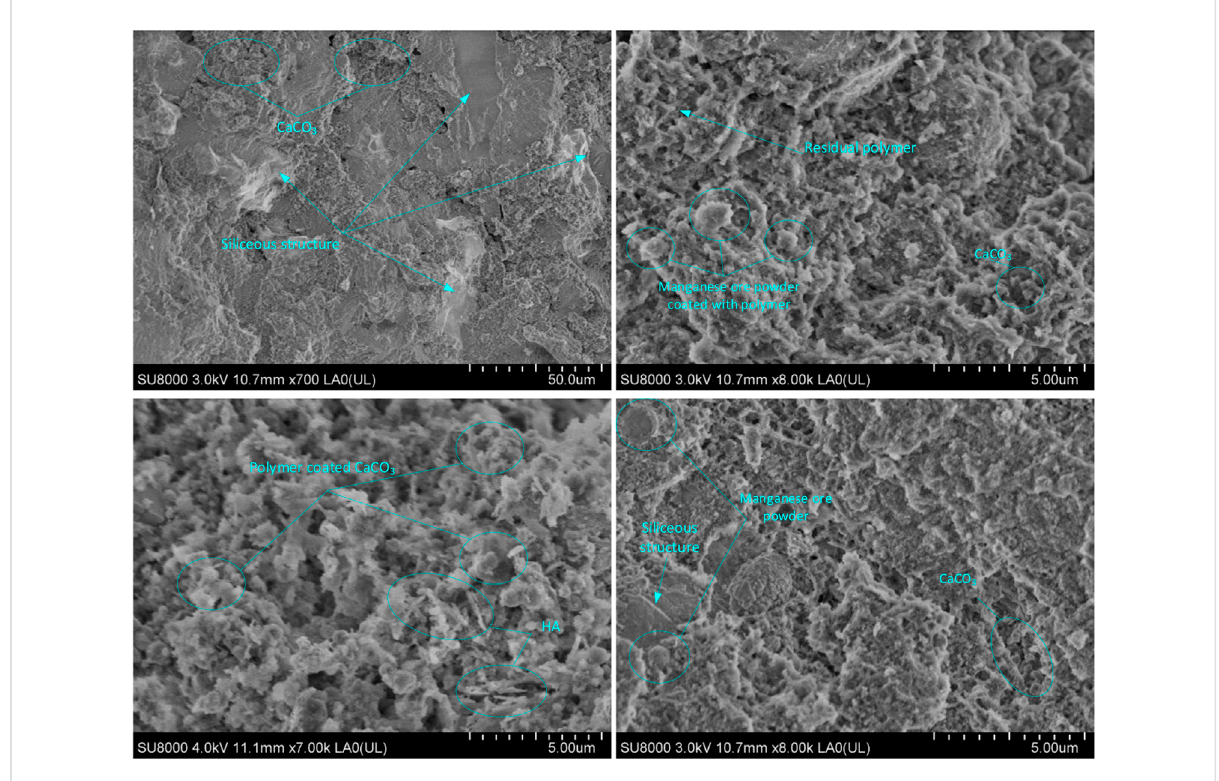
FIGURE 18 Microstructure of corrosion zone of cement paste with high density BFs-HA-composite